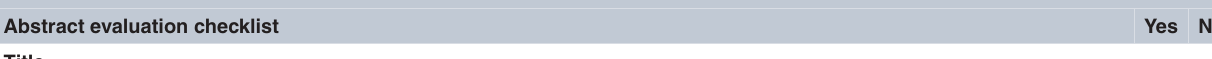
Table 1. CONSORT for Abstracts checklist items 10 , with descriptors by Hays et al . 9 as used for this post hoc analysis. CONSORT for Abstracts